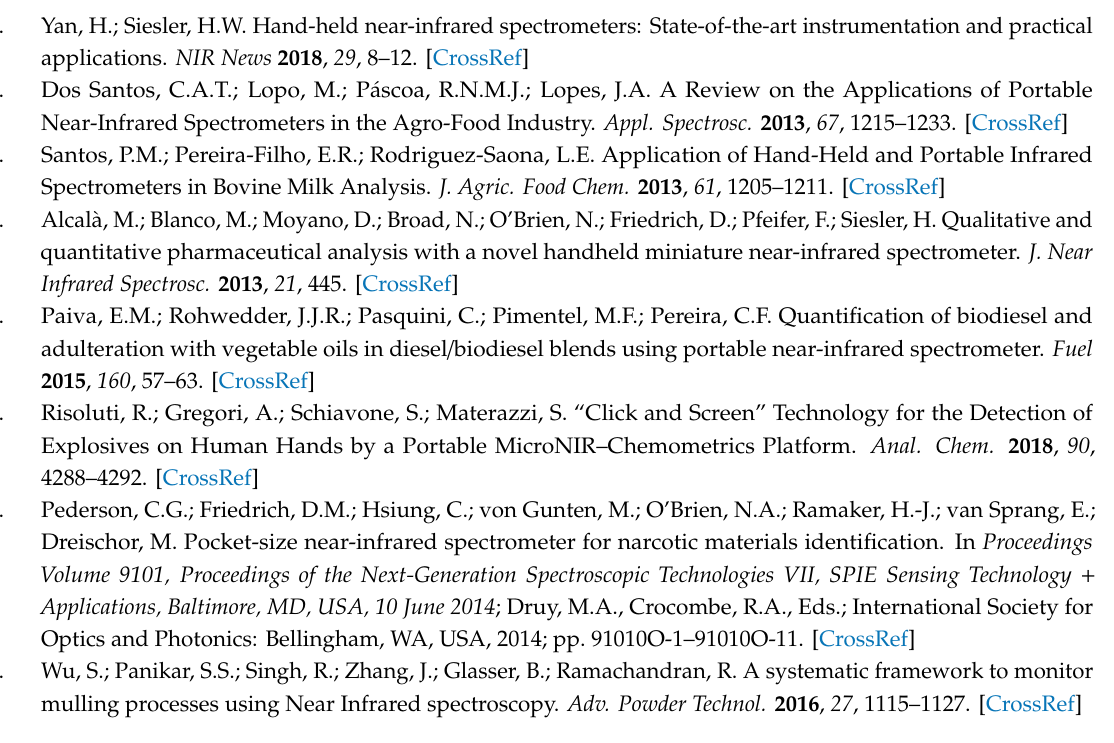
demonstrating instrument-to-instrument